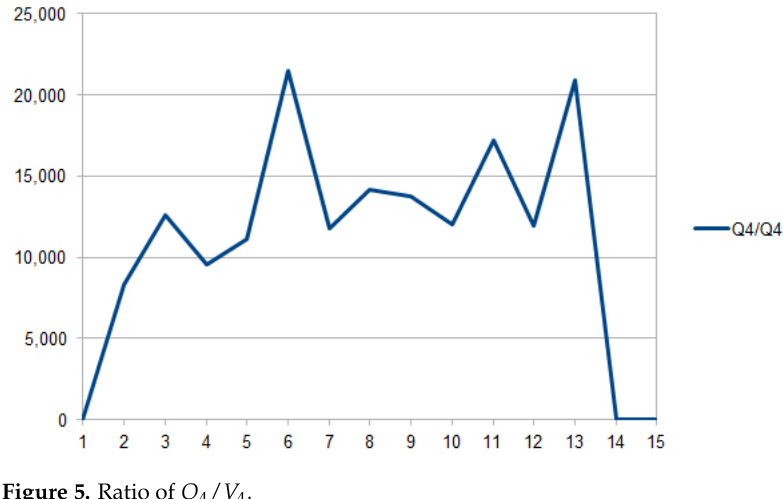
Figure 5. Ratio of Q 4 / V 4 .